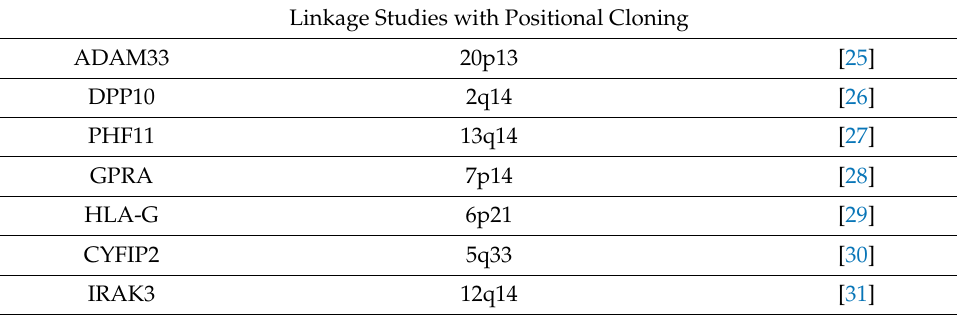
Table 1. Summary of genomic analysis in adult